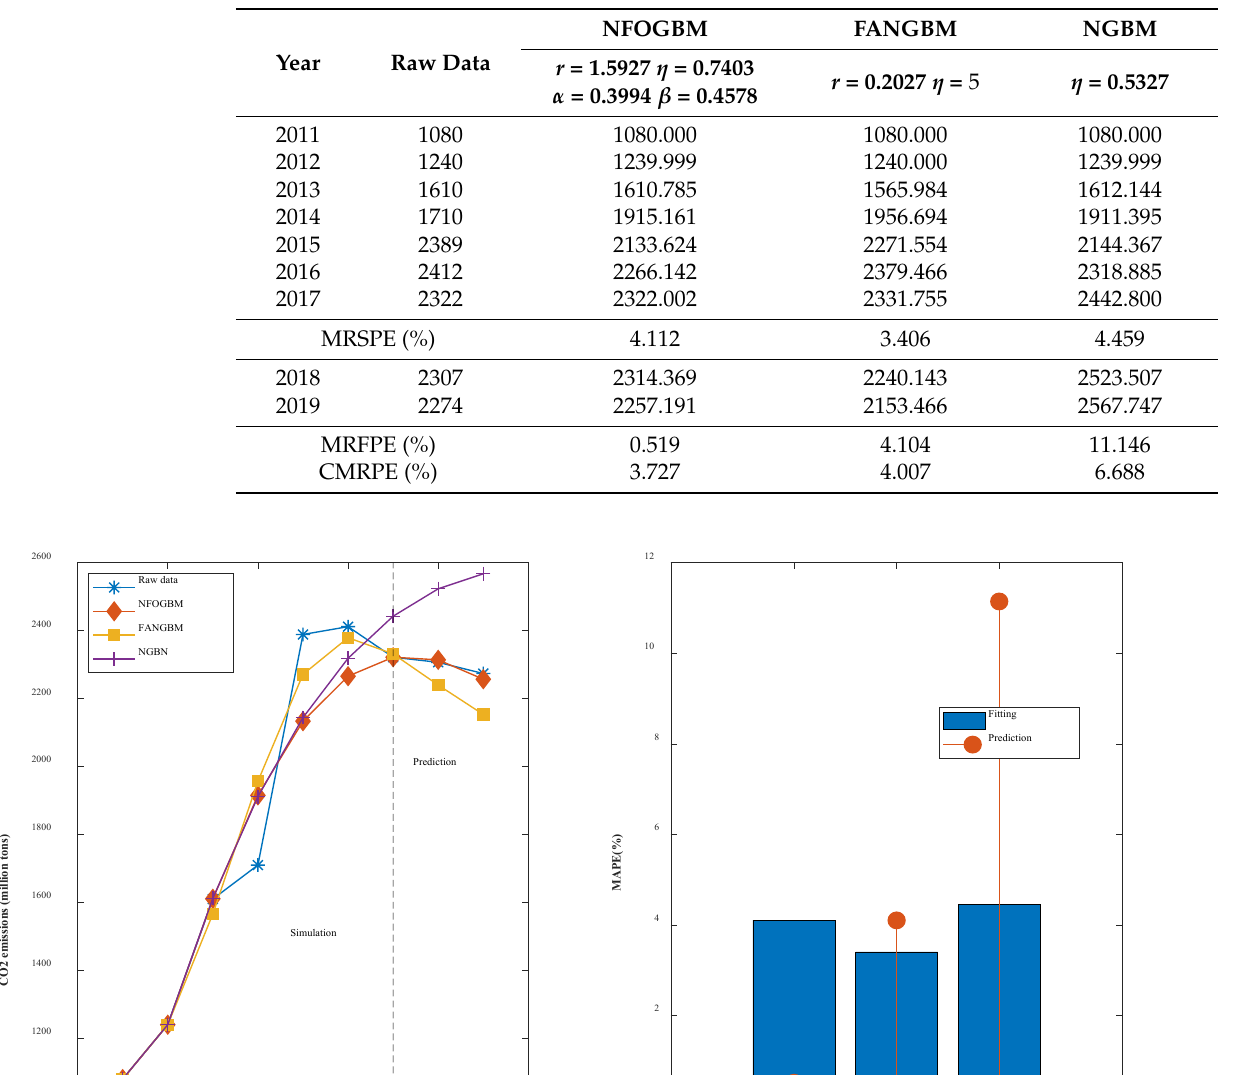
Table 7. Modeling results for CMD.